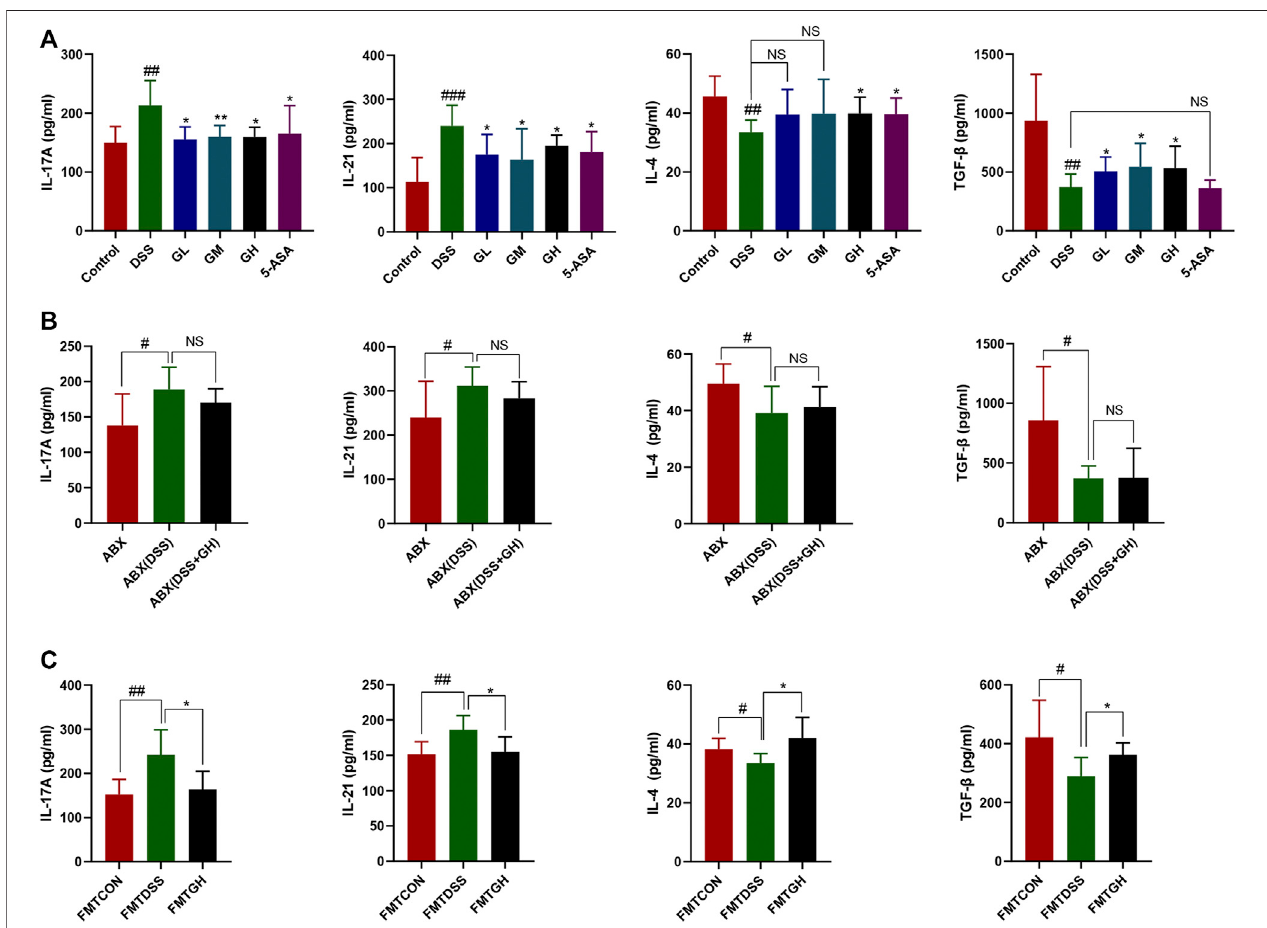
FIGURE10| MGQD and FMT attenuated in fl ammatoryresponse incolonic tissues ofmice withDSS-inducedcolitis. (A) Theexpression levelsofpro-in fl ammation cytokines IL-17A, IL-21 and anti-in fl ammation cytokines IL-4 and TGF- β were determined in colon tissue homogenate using ELISA methods among six groups. Results wereshownasmean ± SD(n (cid:2) 5 – 10).## p < 0.01,### p < 0.001,vscontrolgroup;* p < 0.05,** p < 0.01,vsDSSgroup. (B) IL-17A,IL-21,IL-4andTGF- β cytokineslevels in colon tissue homogenate were measured by ELISA between gut microbiota depletion groups. Results were shown as mean ± SD (n (cid:2) 6 – 10). # p < 0.05, vs